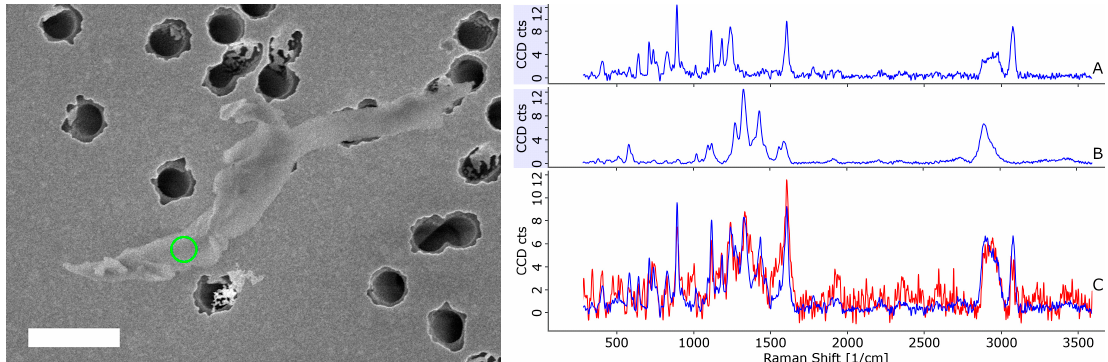
Figure 2. Raman analysis of a cellulose fiber with WHO dimensions found at WP09. ( Left ) SEM image of the fiber with the position and lateral resolution of the Raman laser spot symbolized in green. The length of the scale bar is 1 μm . ( Right ) Raman spectra of ( A ) Polycarbonate of the filter membrane as detected through the 40 nm gold coating; ( B ) Cellulose fiber of wiping paper used at the workplace; ( C ) red: Raman spectrum taken at the indicated position; blue: Superposition of spectrum ( A , B ) fitted to the red spectrum. Atmosphere 2020 , 11 , x FOR PEER REVIEW 15 of 36